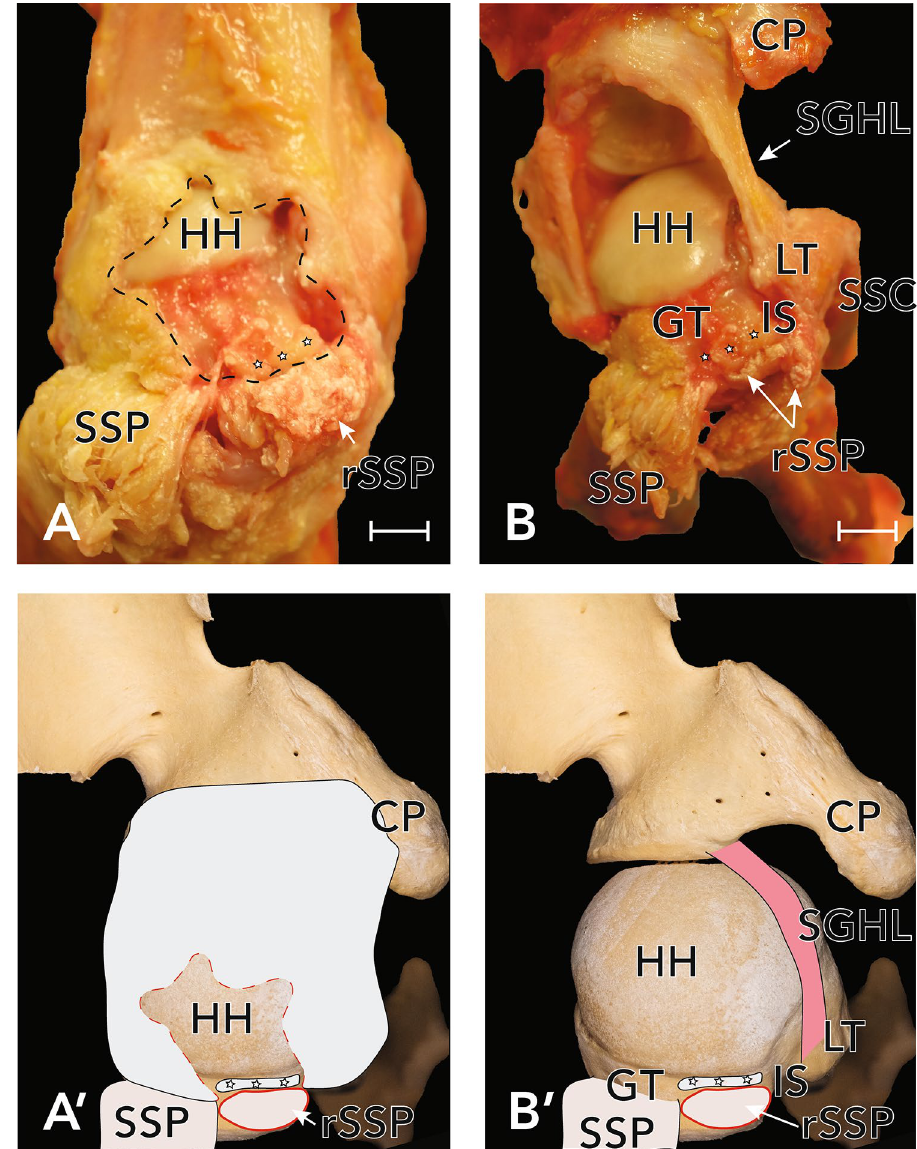
Figure 5. Exemplary view of a right shoulder with partial full-thickness tear of the supraspinatus tendon. ( A ) As the supraspinatus muscle was reflected, the extent of the defect in the underlying capsuloligamentous layer was observed. ( B ) A complete rupture of the CHL was identified, only the SGHL was left intact. Also, the LHB was ruptured. ( A ′ ) and ( B ′ ) Approximation of the photographs as an overlay on humerus and scapula. Asterix mark remnants of the fibrous capsule. HH humeral head, CP coracoid process, GT greater tubercle, LT lesser tubercle, IS intertubercular sulcus, SGHL superior glenohumeral ligament, SSP supraspinatus muscle, SSC subscapularis